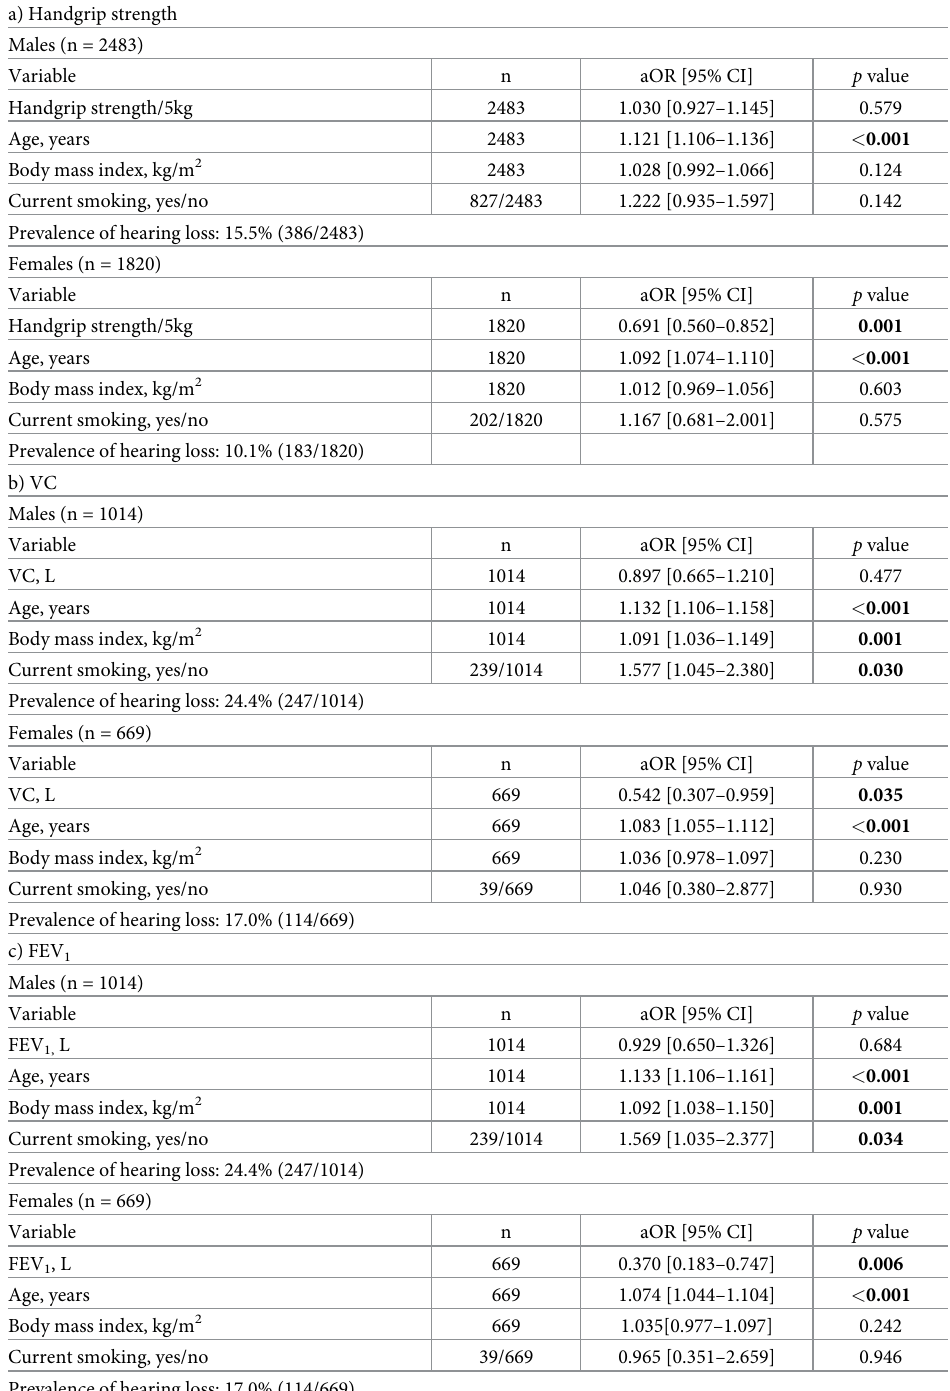
Table 3. Adjusted odds ratios for hearing loss with physical functions stratified by